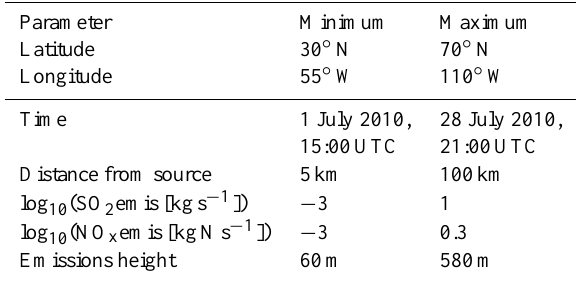
Table 1. Parameter space used to create training data for the P6